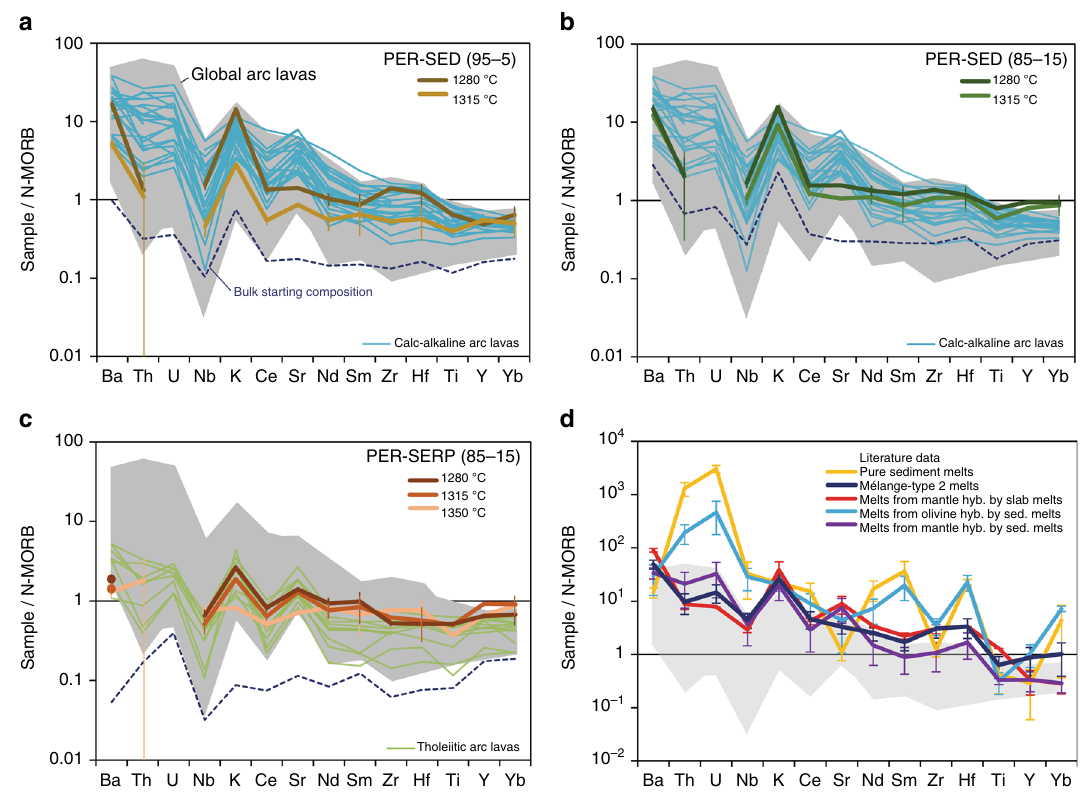
Fig. 6 Trace element composition of experimental melts Normalized trace element concentrations of experimental peridotite-mélange melts ( a – c ) and previously published experimental studies ( d ), compared to global arcs 35 (normalized to MgO = 6 wt.%; gray fi eld), primitive calc-alkaline 33 (light blue) and arc tholeiites 33 (green). The average N-MORB value used in the normalization is from Gale et al. 58 Data from this study are melt compositions with error bars representing 2SE total (2SE internal error propagated with 2SE from calibration curve). K and Ti were analyzed using EPMA. Bulk starting compositions of the three types of experiments are reported as a dotted blue line. Experimental melts from mantle hybridized by slab melts and sediment melts are from Rapp et al. 37 and Mallik et al. 42 , respectively. Experimental melts of olivine hybridized by sediment melts are from Pirard and Hermann 38 . Experimental pure sediment melts are from Skora and Blundy 7 . Experimental melts of a sediment-dominated mélange material (mélange-type 2 melts) are from Cruz-Uribe et al. 40 The literature data are plotted as averages with error bars representing 1